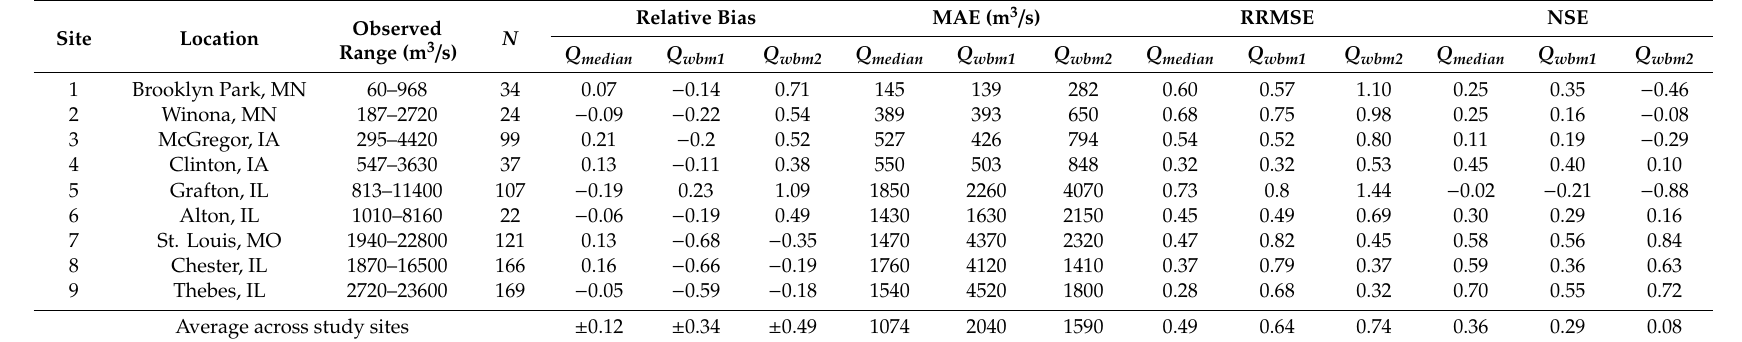
Table 4. Performance of the three Q prior centers ( Q median , Q wbm1 , and Q wbm2 ) for estimating river